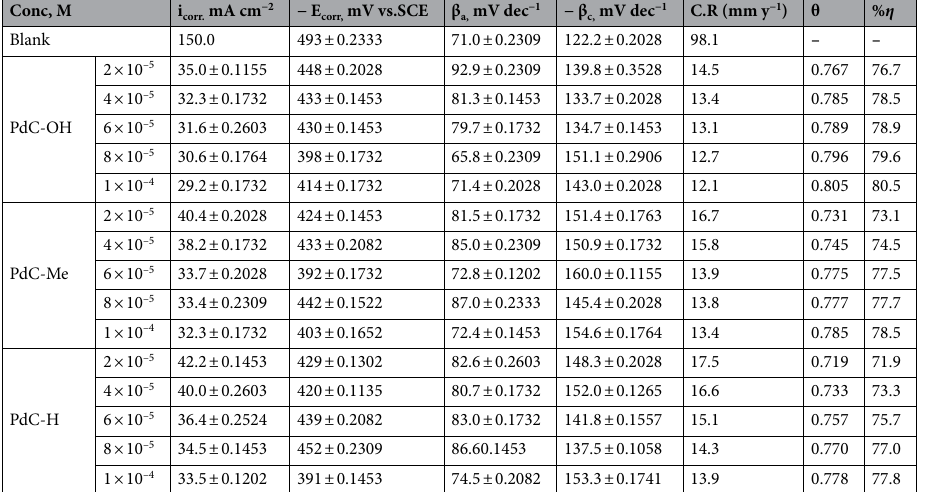
Table 7. Electrochemical parameters from polarization measurements for carbon steel corrosion in 1 M HCl for PdC-OH, PdC-Me and PdC-H derivatives at 25